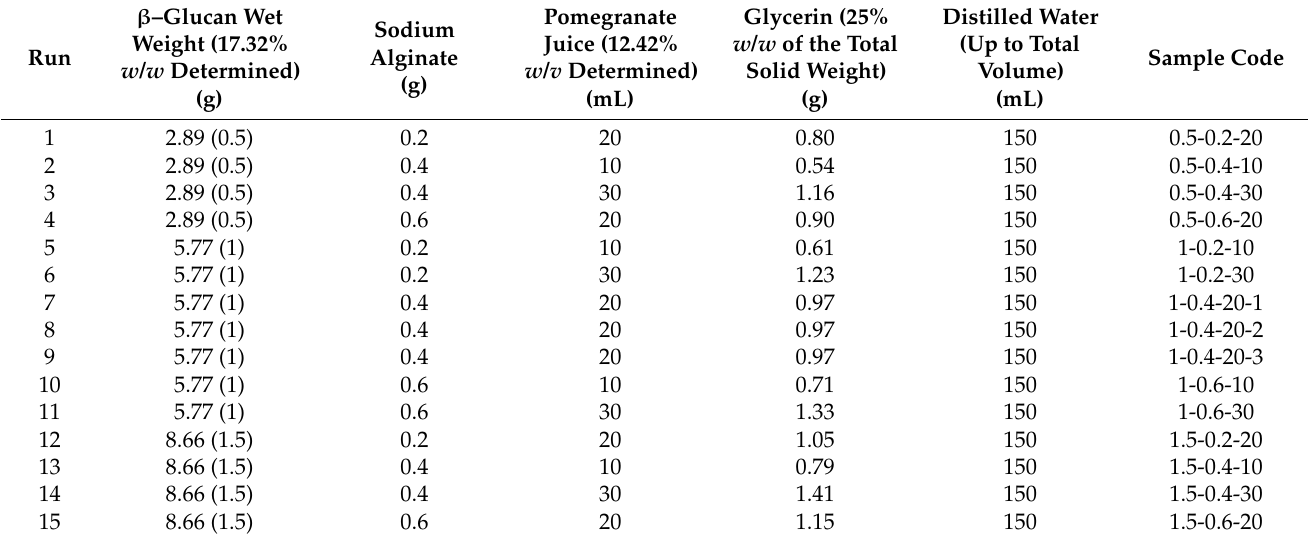
Table 3. Preparation and composition of β –glucan, sodium alginate, pomegranate juice and glycerin in each